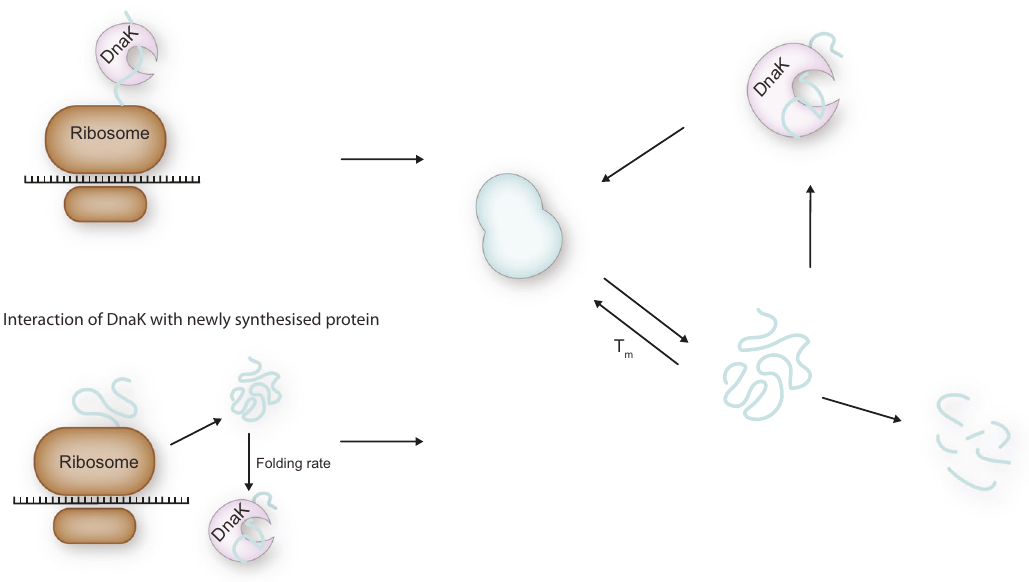
Fig. 9 A model for DnaK interaction with client proteins. Two different factors impact the interaction of DnaK with client proteins: synthesis rate and protein stability. DnaK can act co-translationally with the nascent peptide chain as it exits the ribosome exit tunnel, in which case the DnaK response is expected to be proportional to the translational rate. In addition, DnaK can bind to unfolded newly synthesised protein that has been released from the ribosome. For slow-folding protein, the interaction with DnaK will then also depend on folding rate. Fast folding protein will interact only minimally with DnaK. Fully synthesised proteins are in an equilibrium between folded and misfolded determined by the stability of the protein. Thus, DnaK binding to misfolded protein at folding equilibrium is dependent on protein